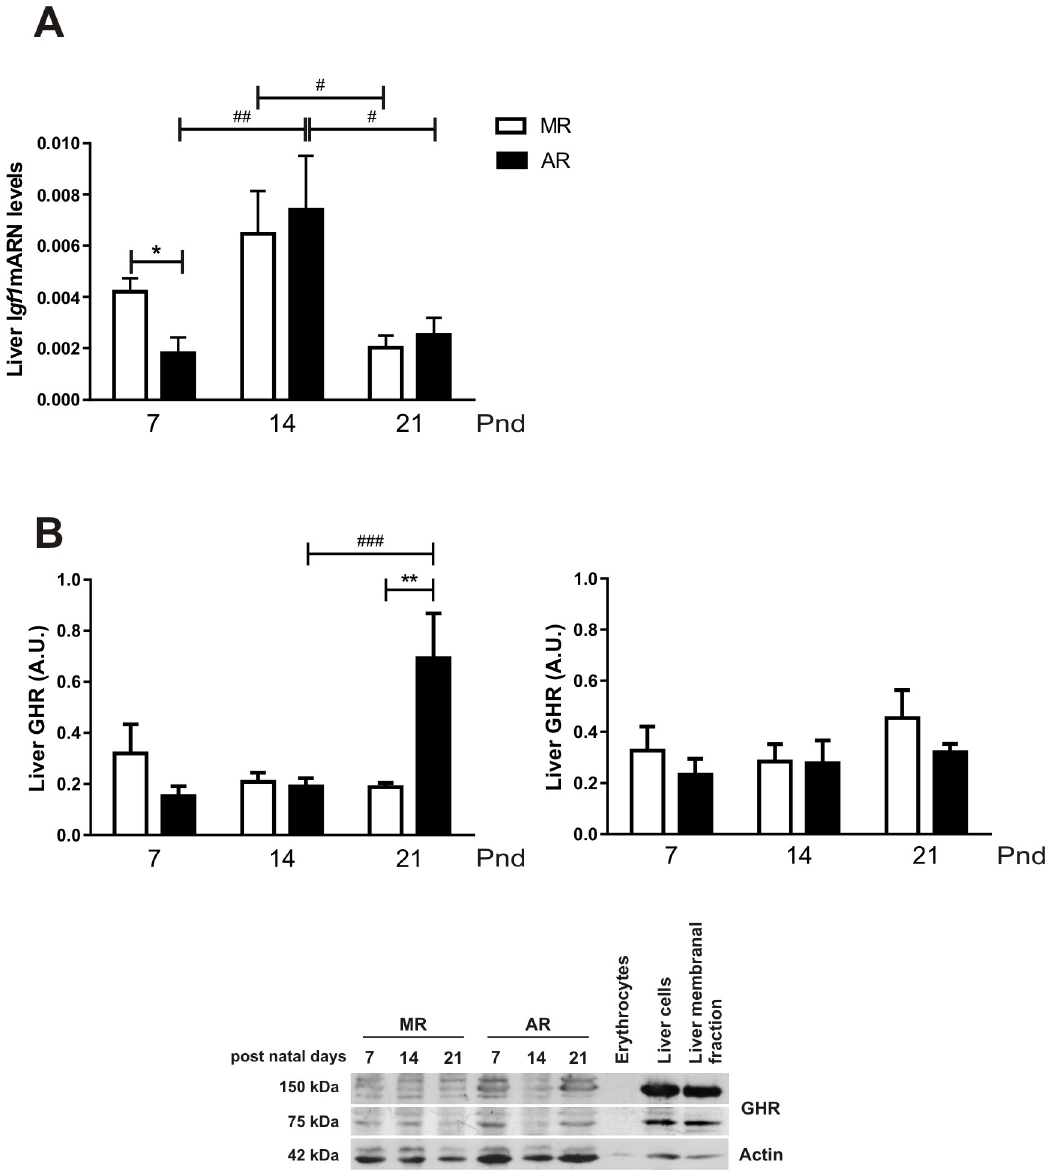
Fig 7. Liver igf1 mRNA levels and GHR in MR and AR pups at pnd7, pnd14 and pnd21. Total mRNA and homogenates of individual livers of 4 hour fasted pups of the different groups and ages were obtained (pnd7, MR and AR n = 8; pnd14 and pnd21, MR and AR n = 6). Igf1 mRNA and GHR levels in pups were normalized according to male adult levels. (A) Relative liver igf1 mRNA levels of MR and AR pups. The values were analyzed by the 2 ΔΔ method using the adult values as control. Differences in the growth factor mRNA were compared by 2 way-ANOVA, followed by Tukey´s multiple comparisons posttest for differences between ages, # P < 0.05, ## P < 0.01 and by Sidak´s multiple comparisons posttest for differences between MR and AR groups, � P < 0.05. (B) Liver GHR levels, left panel corresponds to 75kDa receptor bands (monomeric) and right panel corresponds to 150kDa receptor bands (dimeric). Data correspond of individual samples, n = 6. Only in the monomeric receptor levels, statistical differences were obtained by 2 way-ANOVA, followed by Tukey´s multiple comparisons posttest for differences between ages in both groups, ## P < 0.01, ### P < 0.001, by Sidak´s multiple comparisons posttest for differences between MR and AR groups, �� P <